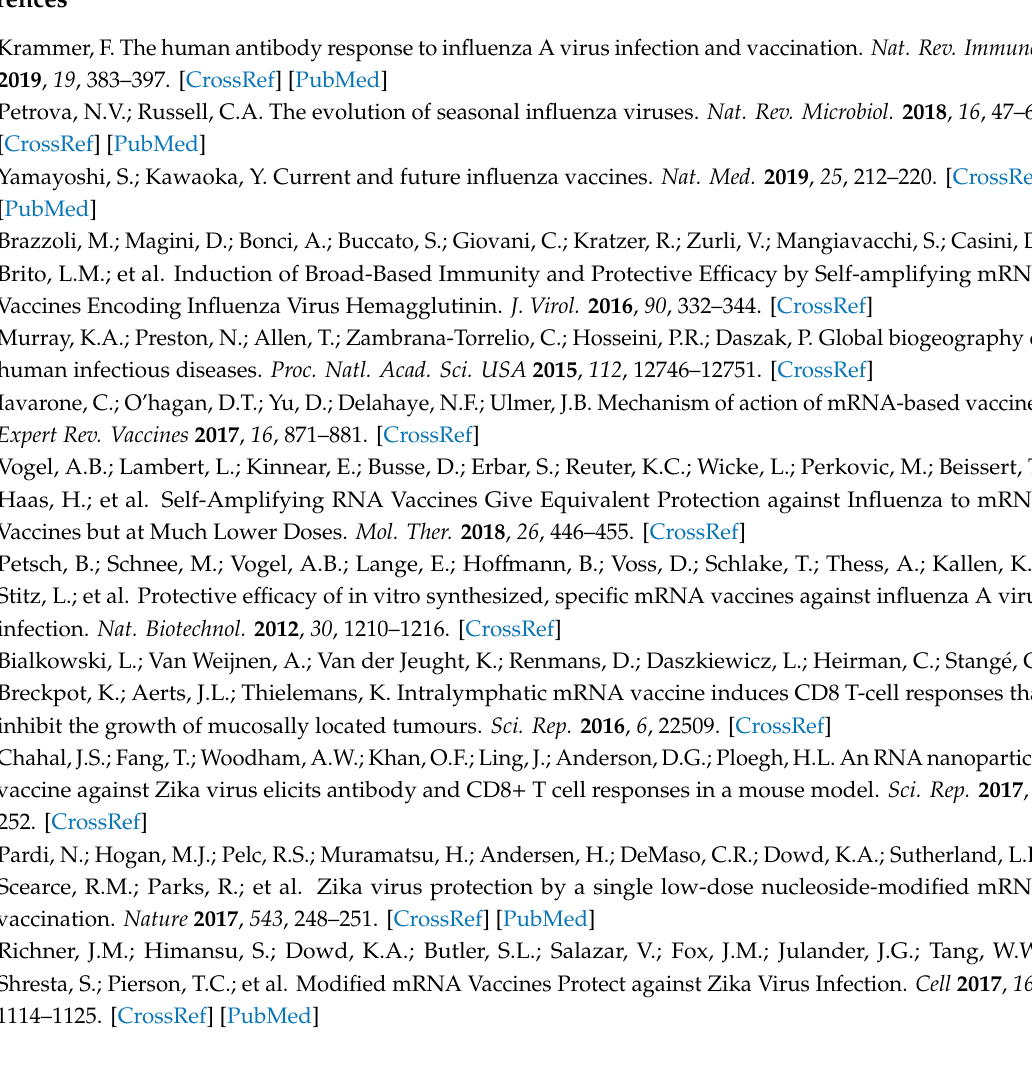
Figure S1. (a) Agarose gel electrophoresis of pGEM-EGFP-n1 / n2 / n3 digested by Xho I enzyme. (b) Agarose gel electrophoresis of pGEM-H3HA-n1 / n2 / n3 digested by Xho I enzyme; Figure S2. The gating strategys of flow cytometry to detect the percentage of EGFP positive cells. (a) The control group. (b) The Cap-mEGFP-n1 group. (c) The Cap-mEGFP-n2 group. (d) The Cap-mEGFP-n3 group; Figure S3. Size distributions of (a) LNP. (b)